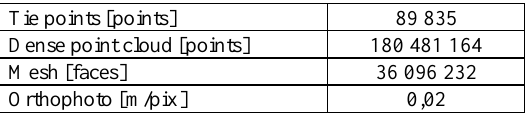
Table 4. Photogrammetric results.